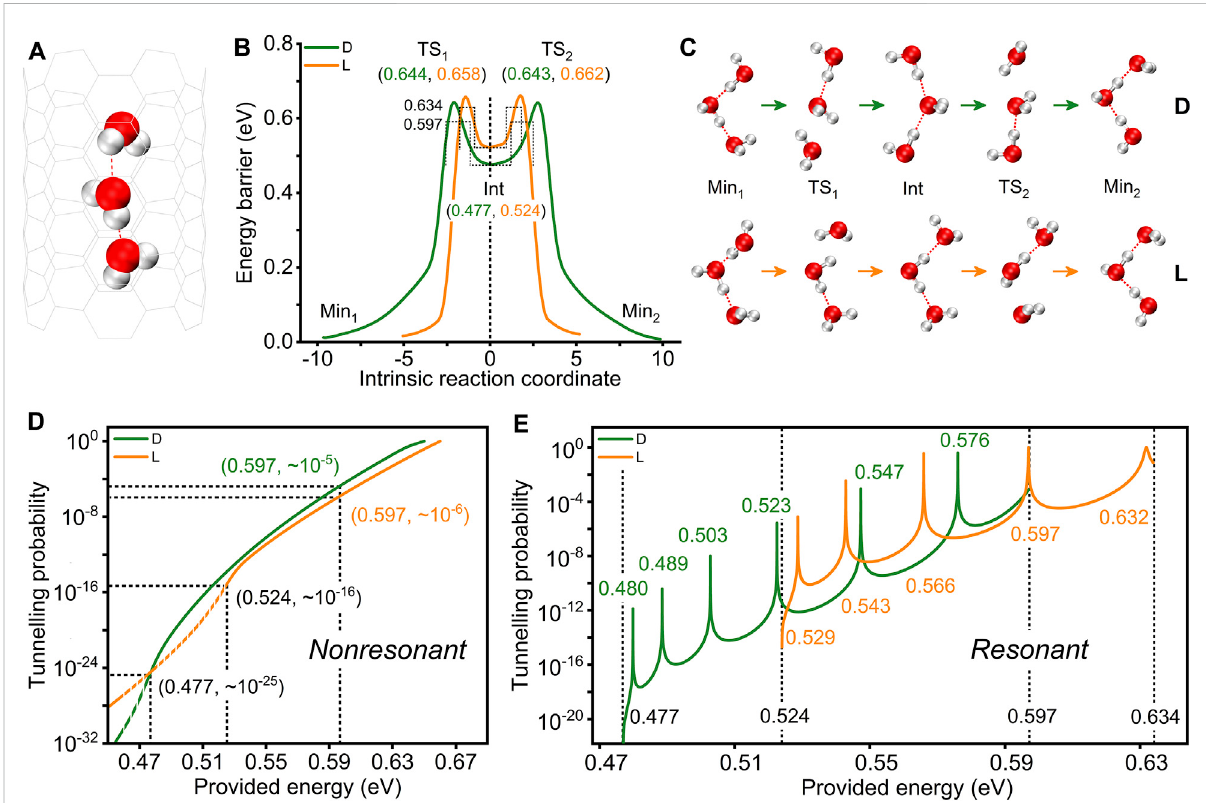
FIGURE 1 Different mechanisms by which the water chain with three water molecules in theCNT achieves reorientation. (A) Model of thecon fi ned water chain. (B) PESsofthewaterchain fl ipping.Dottedlinesaretheequivalentsquareenergybarriersobtainedby fi ttingthedoublebarriersofthePESs. (C) Water chain structures corresponding to each extreme point on the PESs. (D) Variation in the quantum tunnelling probability with provided energy without considering coherence. The dotted and solid lines indicate the tunnelling probability at provided energies below and above the intermediate energies, respectively. (E) Variation in the quantum tunnelling probability with provided energy considering coherence. According to the square barriers, the energy height provided are 0.477 – 0.597 eV and 0.524 – 0.634 eV, corresponding to the two reaction paths. The dotted lines represent the provided energy at the start or end of the two reaction paths. Green and yellow represent the reaction paths containing D-type and L-type defective intermediates,